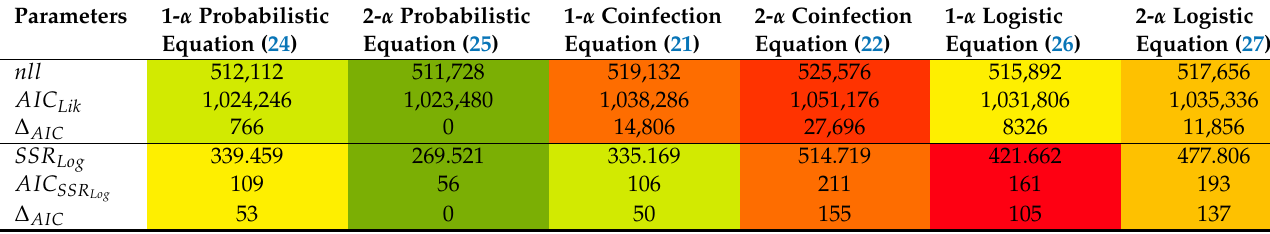
Table 3. The 2-alpha probabilistic model fits the coinfection data with best quality. We fitted a series of mathematical models (see Section 2 and Figure 2) that make different assumptions on how coinfection of individual cells with two different viruses occur to the data on viral spread. The models were fitted using the binomial distribution-based likelihood method (Equation (33)) or the least squares method with a log transform of the data (Equation (37)). AICs were calculated using Equations (38) and (40), for the likelihood and least squares methods respectively. Values for nll , AIC Lik , and AIC LS rounded to the nearest whole number. ∆ AIC for both methods are calculated by taking the AIC score from the model and method in question and subtracting it from the lowest AIC in its corresponding row. Coloring follows the same principle as in Table 2. In fitting models using least squares to log-transformed data we used the following values for the limit of detection of the frequency